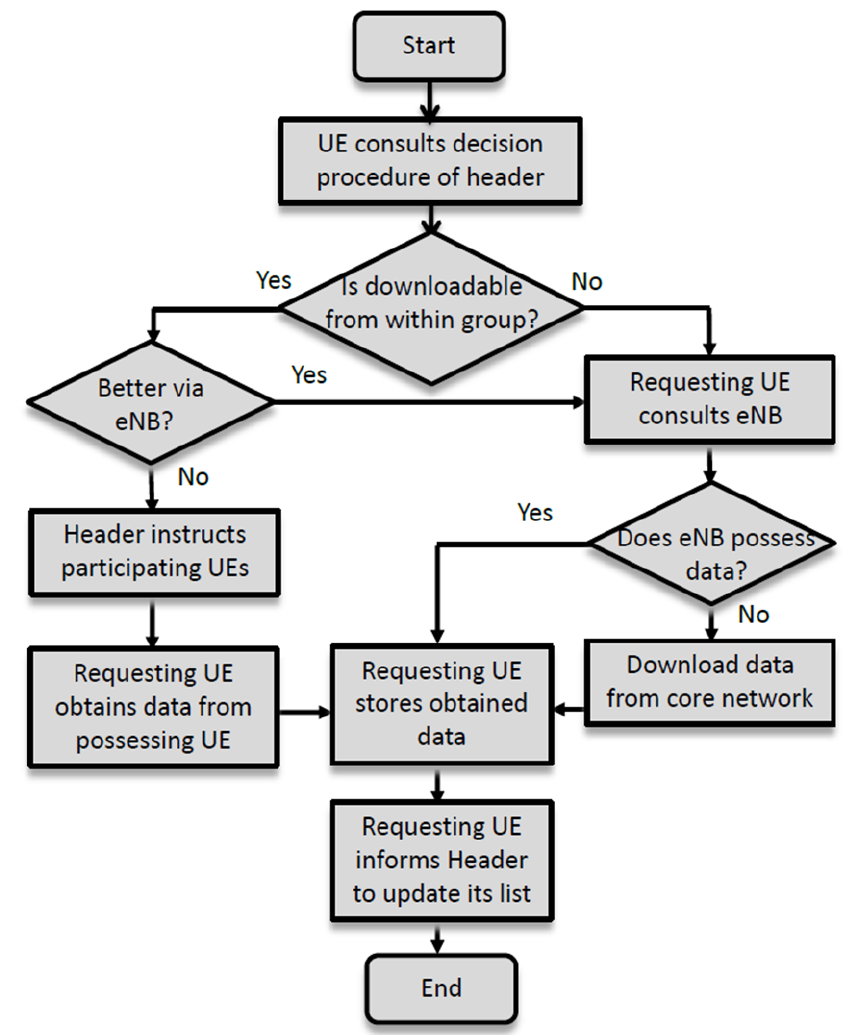
Figure 4. The control flow for D2D group communication.